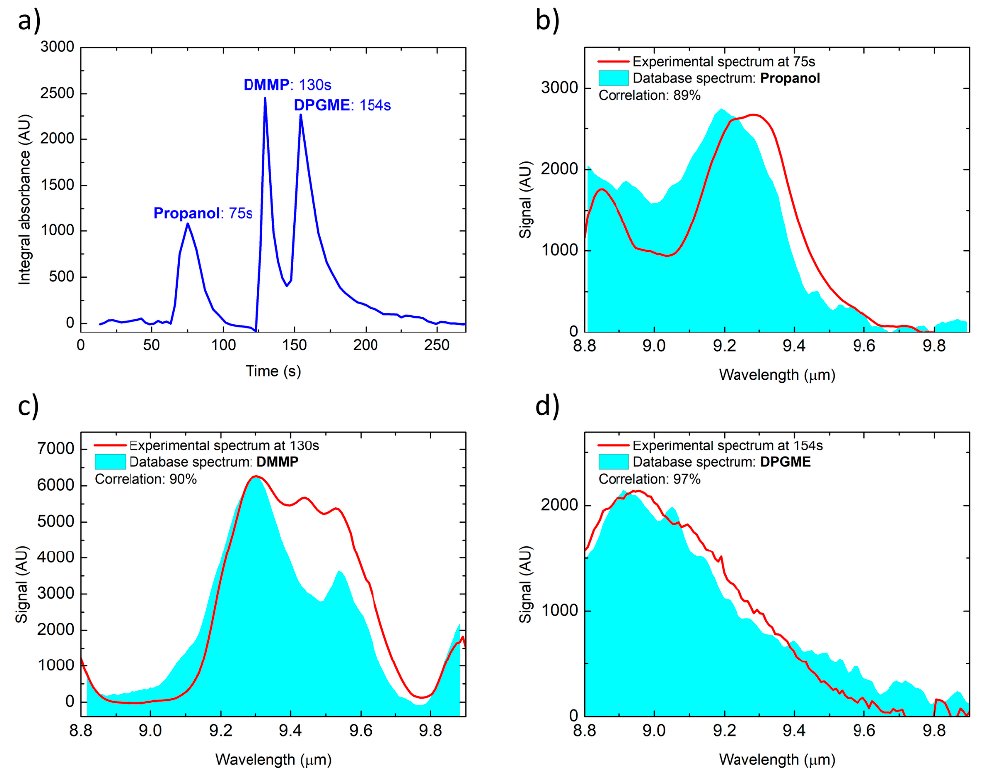
Figure 11. Total absorption chromatogram ( a ) of a 3-component mixture, and the correctly identified spectra of Propanol, DMMP and dipropylene glycol methyl ether (DPGME) at the respective retention times ( b – d ).